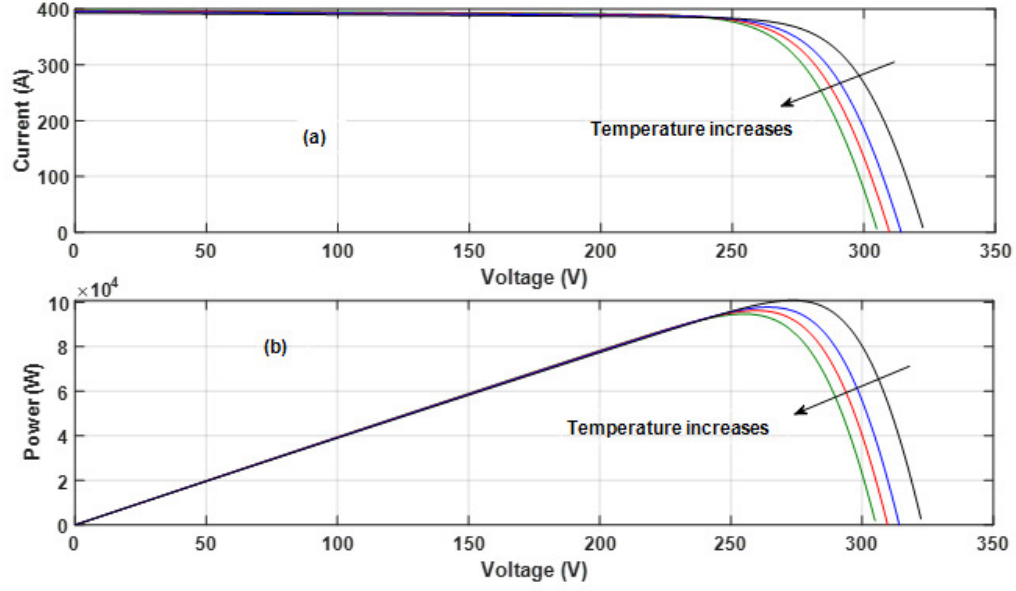
Figure 4. PV system characteristics at cell temperature change a- I-V responses b- P-V